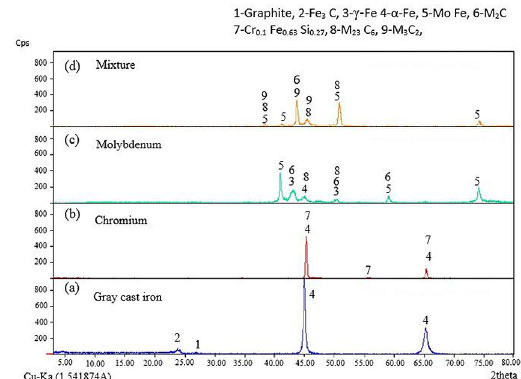
Figure 4. X-ray diffraction pattern for (a) grey cast iron substrate, (b) Cr-added clad, (c) Mo-added clad and (d) Cr-Mo mixture clad zone. A decrease in the α-Fe phase intensity in the cladding sample was due to the phase transformation at high heating and cooling rates. In the cladding zone, no graphite was observed because at the high temperature of molten pool, the graphite is diffused to the substrate region during the remelting processing 7 . However, in the interface zone, some graphite phases remained due to the reduced heat input as the energy travelled into the surface. The carbide formation phase in the cladding layer was due to the high concentration of Cr and Mo particles, along with the high carbon composition of grey cast iron substrate. Although both Cr and Mo are carbide formers, Mo particles in the cladding surface produced